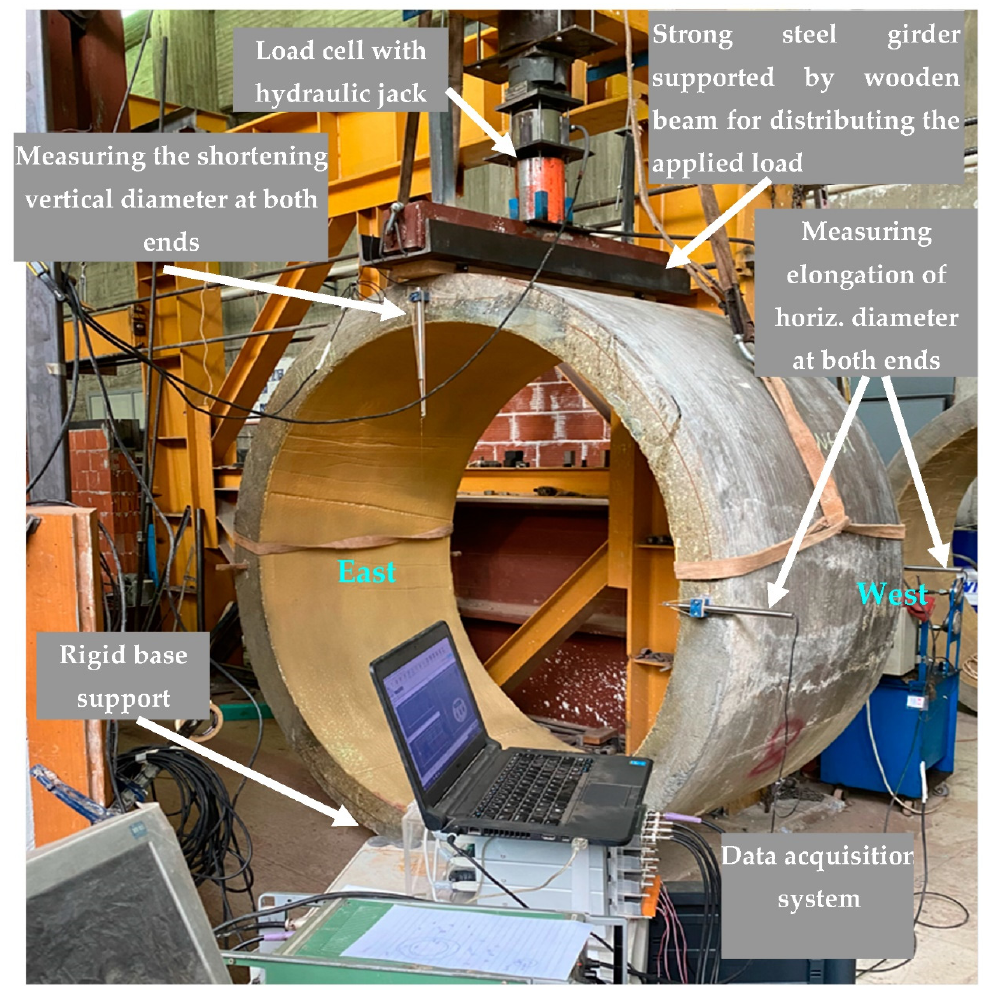
Figure 11. Experimental set-up for testing the PCCP pipe specimens under a three-edge bearing loading arrangement.